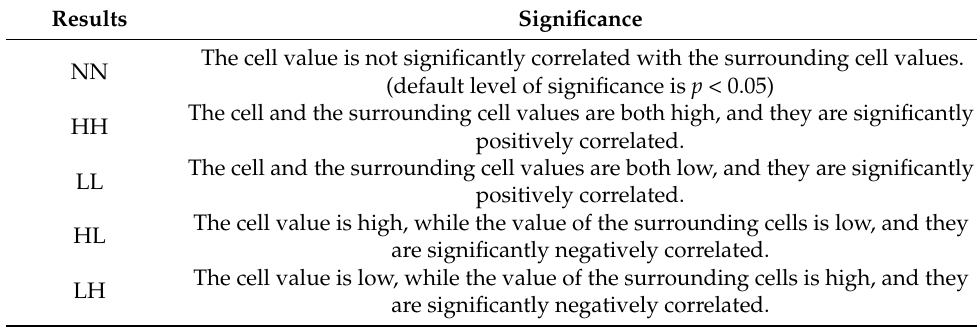
Table 1. Results and significance of LISA.